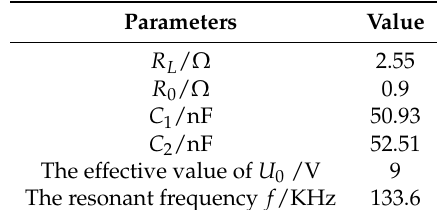
Table 2. Parameters of the components of this WPT system.